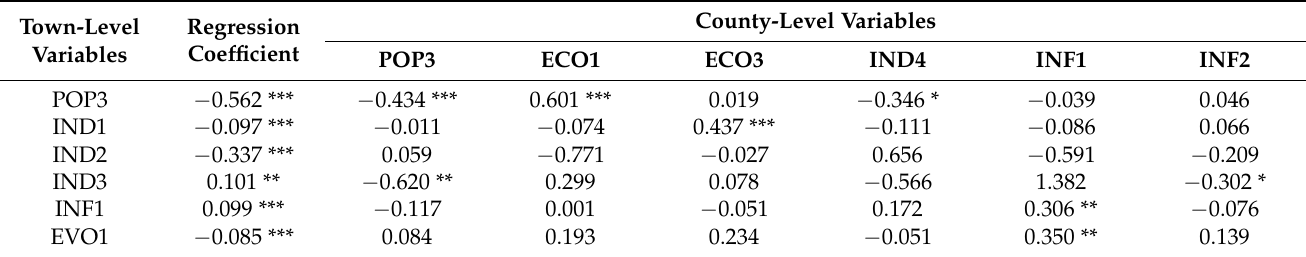
Table 6. The cross-level impact of county-level towns on ordinary